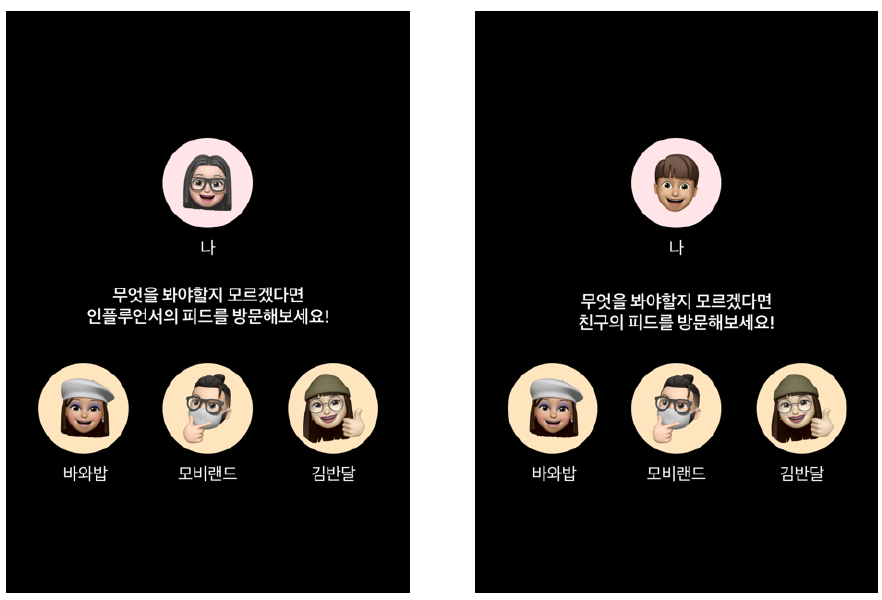
Figure 3. Stimuli of both information sources’ conditions: influencer ( left ) and online-friend ( right ).